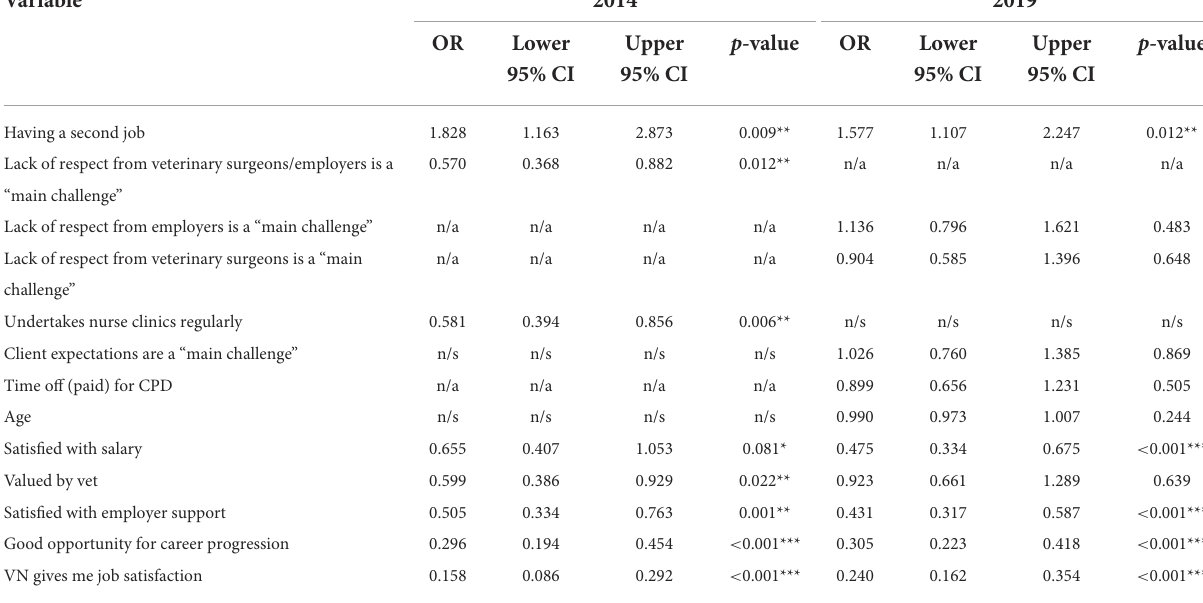
TABLE 5 Comparison of 2014 and 2019 multivariable models (adjusted odds ratios).